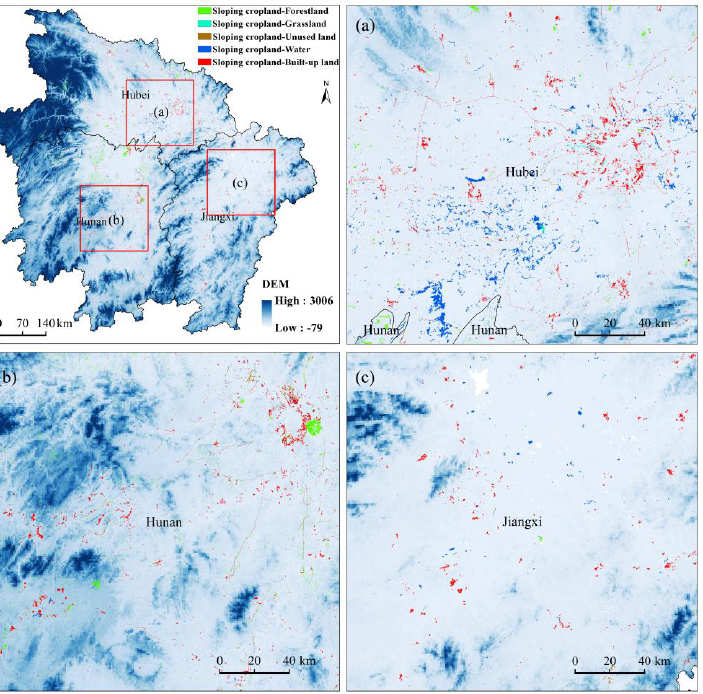
Figure 14. Spatial distribution of sloping cropland transfers to other land uses. ( a ) Selected typical region in Hubei Province. ( b ) Selected typical region in Hunan Province. ( c ) Selected typical region in Jiangxi Province.